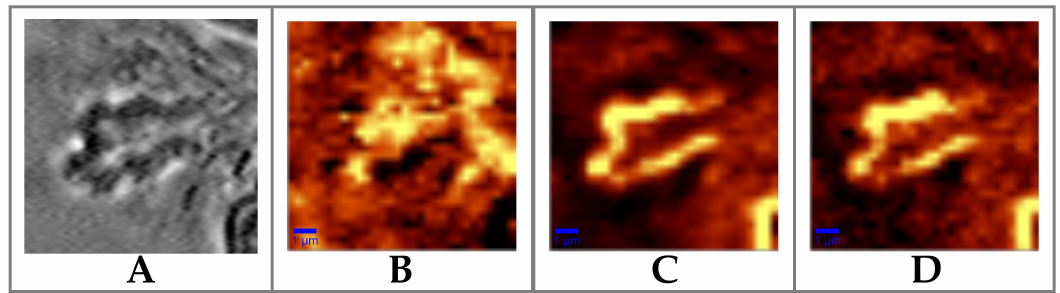
Figure 3. ( A ) Bright-field image of a ferning dentrite and relative Raman images obtained selecting the lipids band area ( B ) 2800–2900 cm − 1 , ( C ) the proteins band 2900–3000 cm − 1 and ( D ) water band from 3100 to 3700 cm − 1 . The scale bar is 1 µ